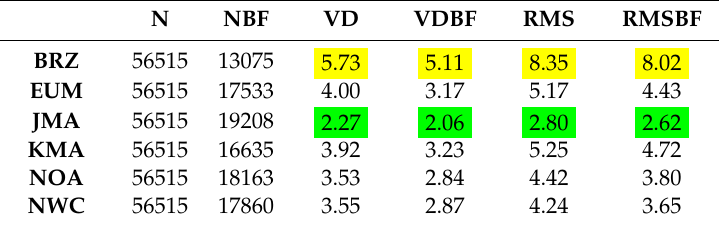
Table 14. Experiment 2: The same as Table 13, but with CQI >=